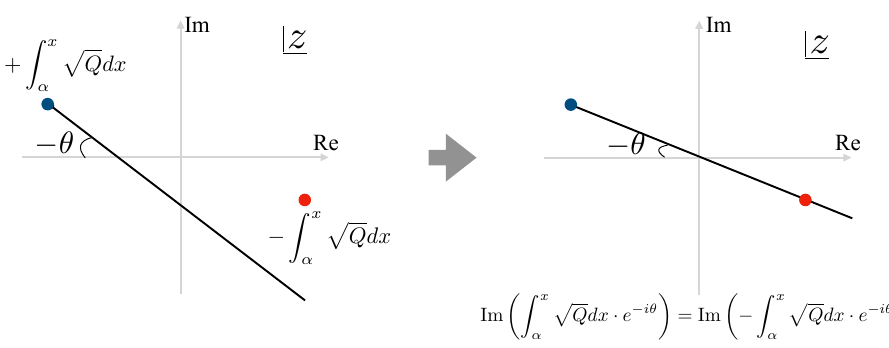
Figure 2 . The black line indicates the integration path on the Borel plane, the blue circle is the endpoint of the integral path and the red circle indicates the singularity of B [ ψ ±